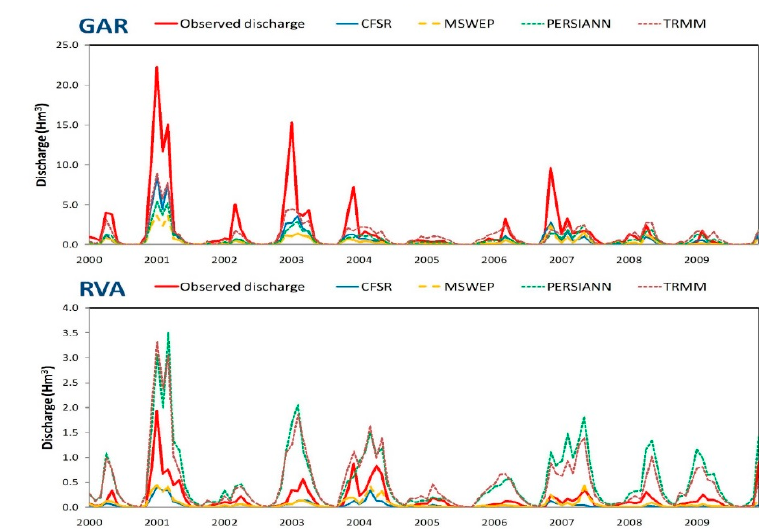
Figure 6. Observed and simulated monthly flow hydrographs for the different datasets using the AEMET_G-calibrated GR2M during the calibration and validation periods (2000–2009).